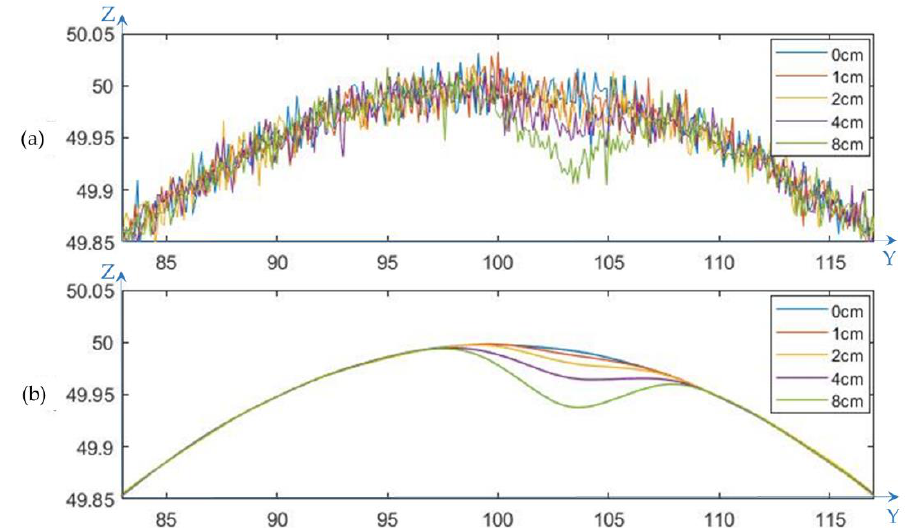
Figure 7. The profile obtained by simulating the subsidence center for all data (m): ( a ) interpolation result; ( b ) Gaussian smoothing result.